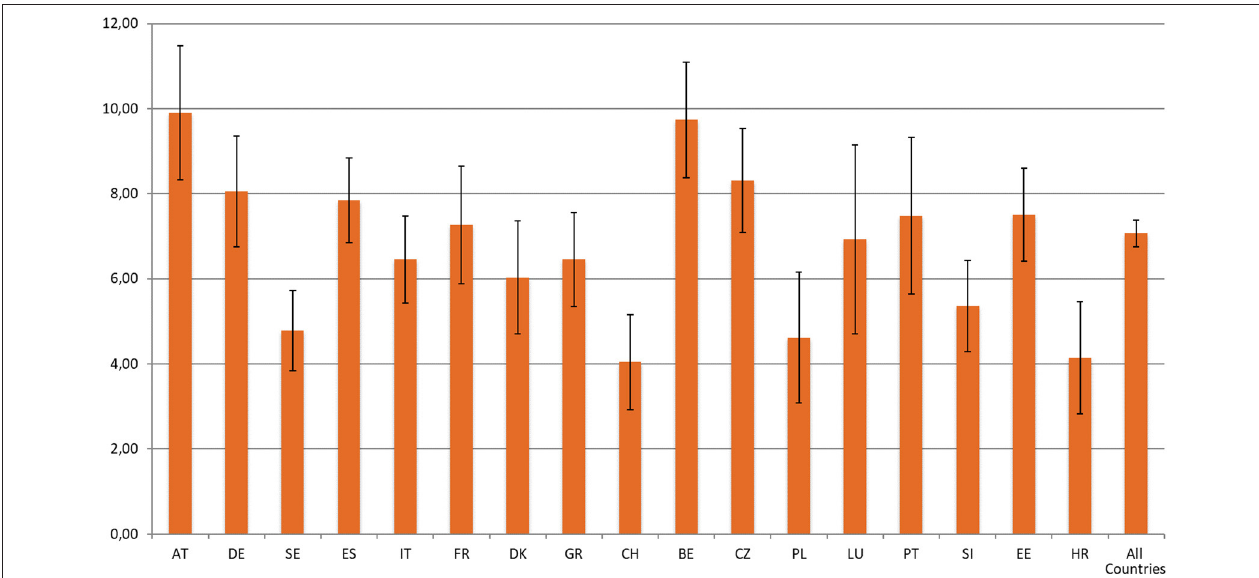
FIGURE 1 | Prevalence of spouse caregiving provided inside the household by individuals aged 65 + , according to country. Source: SHARE, release 7.0.0., wave 6, weighted data, N = 26,301. Brackets denote 95% confidence intervals. Countries: Austria (AT); Germany (DE); Sweden (SE); Spain (ES); Italy (IT); France (FR); Denmark (DK); Greece (GR); Switzerland (CH); Belgium (BE); Czech Republic (CZ); Poland (PL); Luxembourg (LU); Portugal (PT); Slovenia (SI); Estonia (EE); Croatia (HR).